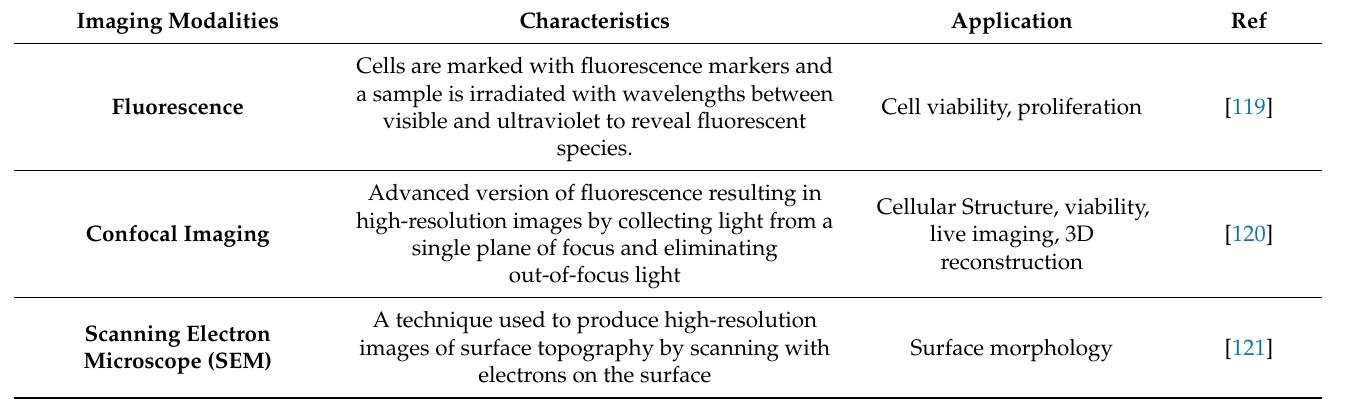
Table 6. Common advanced imaging techniques used to analyze 3D tissue models and live cells within